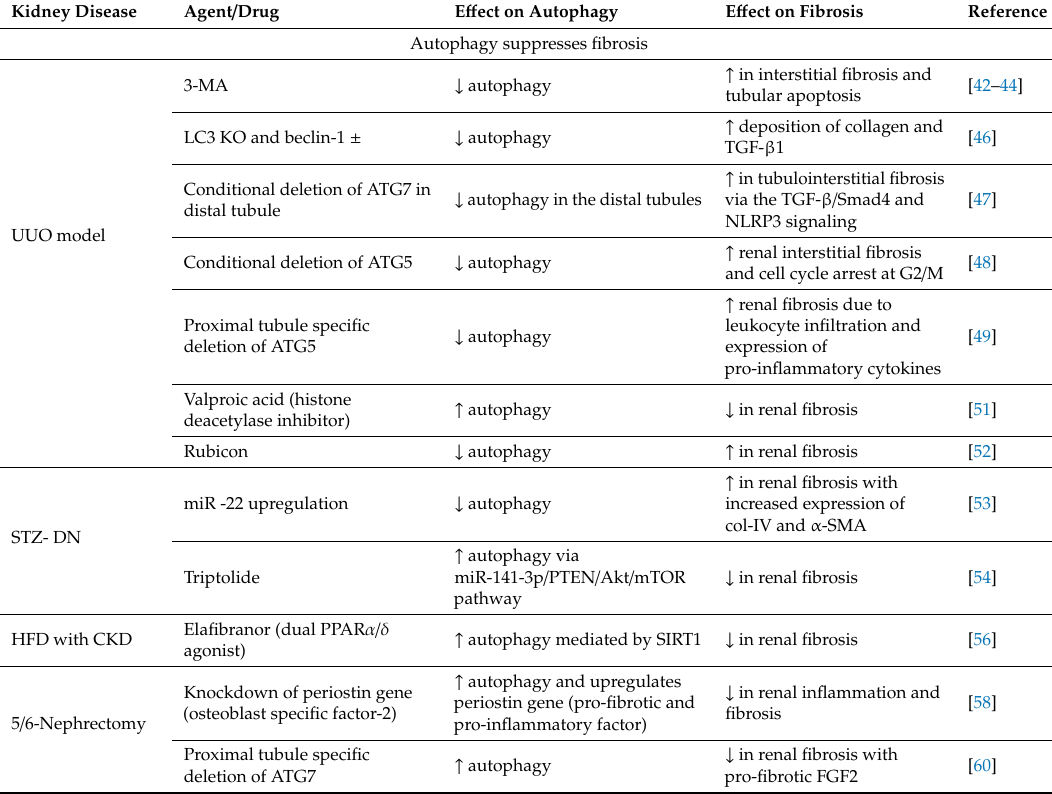
Table 1. Autophagy in renal interstitial